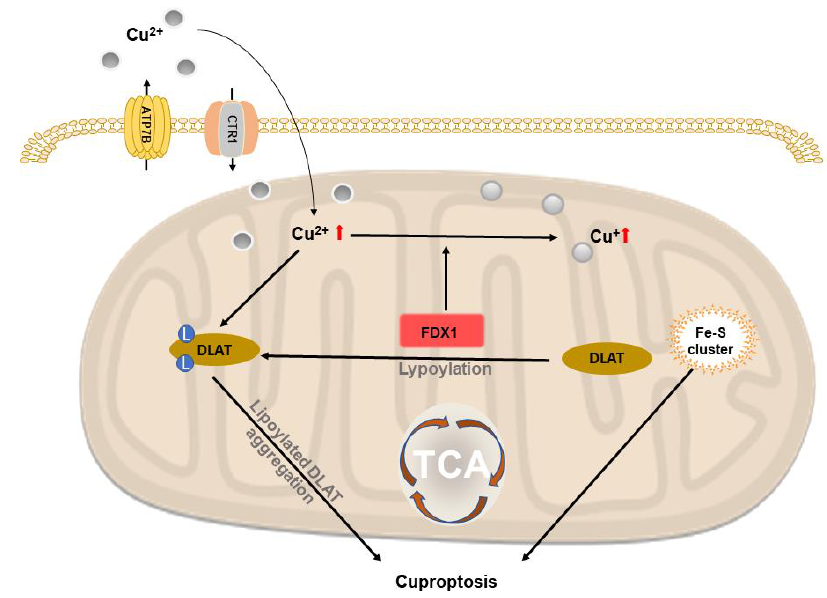
Figure 5. Schematic representation of copper-based cuproptosis. Accumulated intracellular Cu2+ is combined with lipoylated DLAT that induces oli- gomerization of lipoylated DLAT, which promotes cell death by cuproptosis. FDX1 re- duces Cu2+ to Cu+ that inhibits biosynthesis of Fe-S protein and induces cell death.